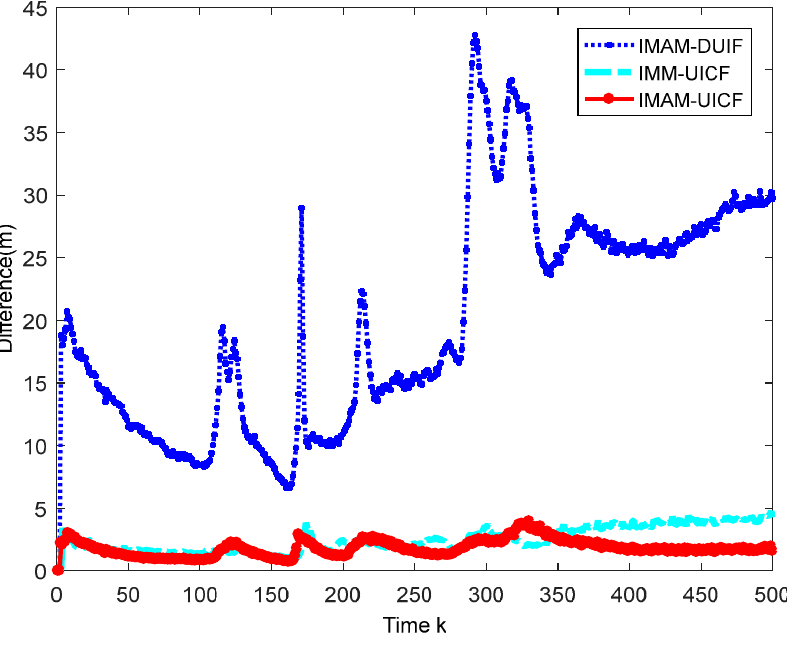
Figure 10. The disagreements of the three algorithms.